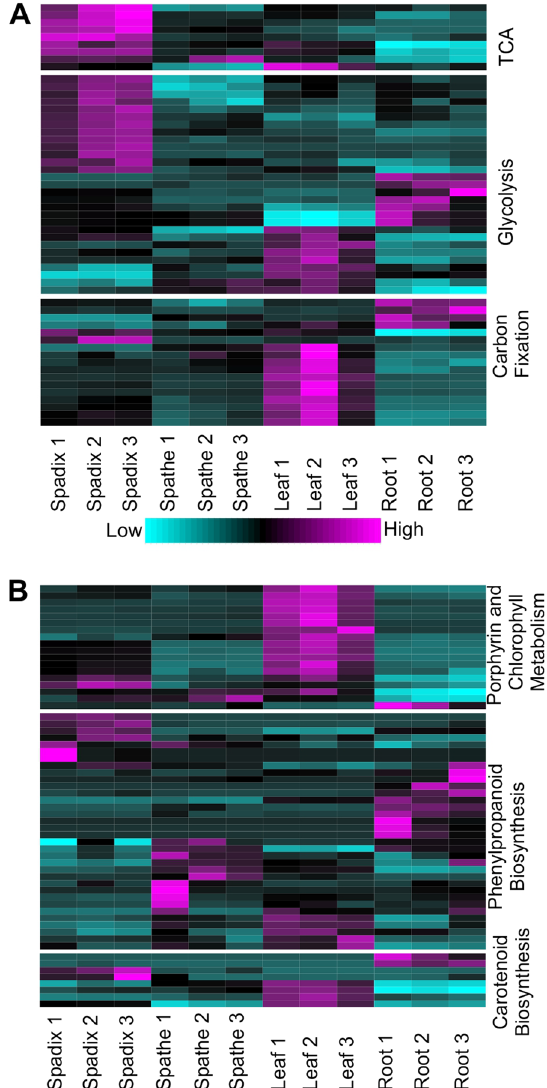
Figure 5. Expression patterns of A . amnicola unigenes assigned to metabolic and pigment biosynthetic pathways in spadix, spathe, leaf, and root. ( A ) Differentially expressed unigenes found in the TCA cycle, glycolysis, and carbon fixation pathways. ( B ) Differentially expressed unigenes assigned to porphyrin and chlorophyll metabolism, phenylpropanoid biosynthesis, and carotenoid biosynthesis